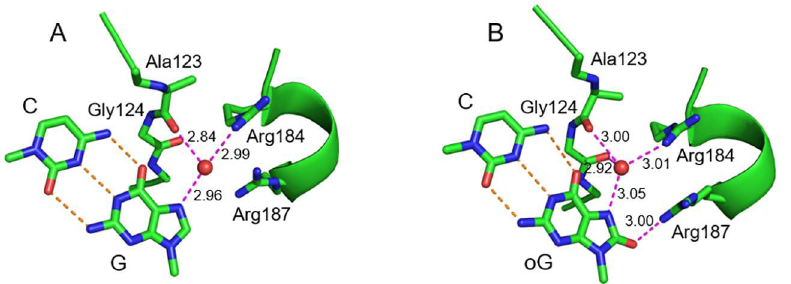
Fig 2. Structures of the G:C pair in the Eco RI recognition site from molecular dynamic simulation. The representative snapshots (10 ns) for native (A) and oxoG-modified (B) cognate site are shown. Carbon atoms and secondary structure elements are colored green, oxygens, red, nitrogens, blue. For DNA, only the G:C or oxoG:C base pair is shown. Orange dashed lines indicate Watson—Crick bonds, magenta dashed lines show hydrogen bonds with the protein formed by G or oxoG directly or through the interface water molecule(red ball). Lengths of hydrogen bonds ( Å ) are shown next to the lines.